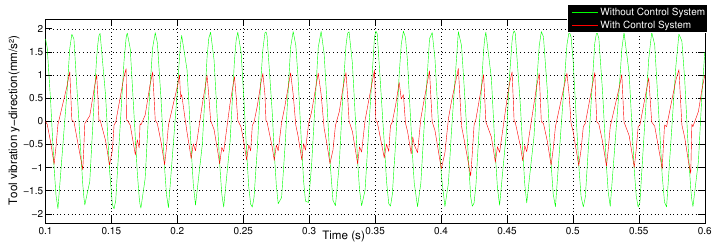
Figure 9. Tool vibration along y -direction using DSMC-T1 fuzzy.